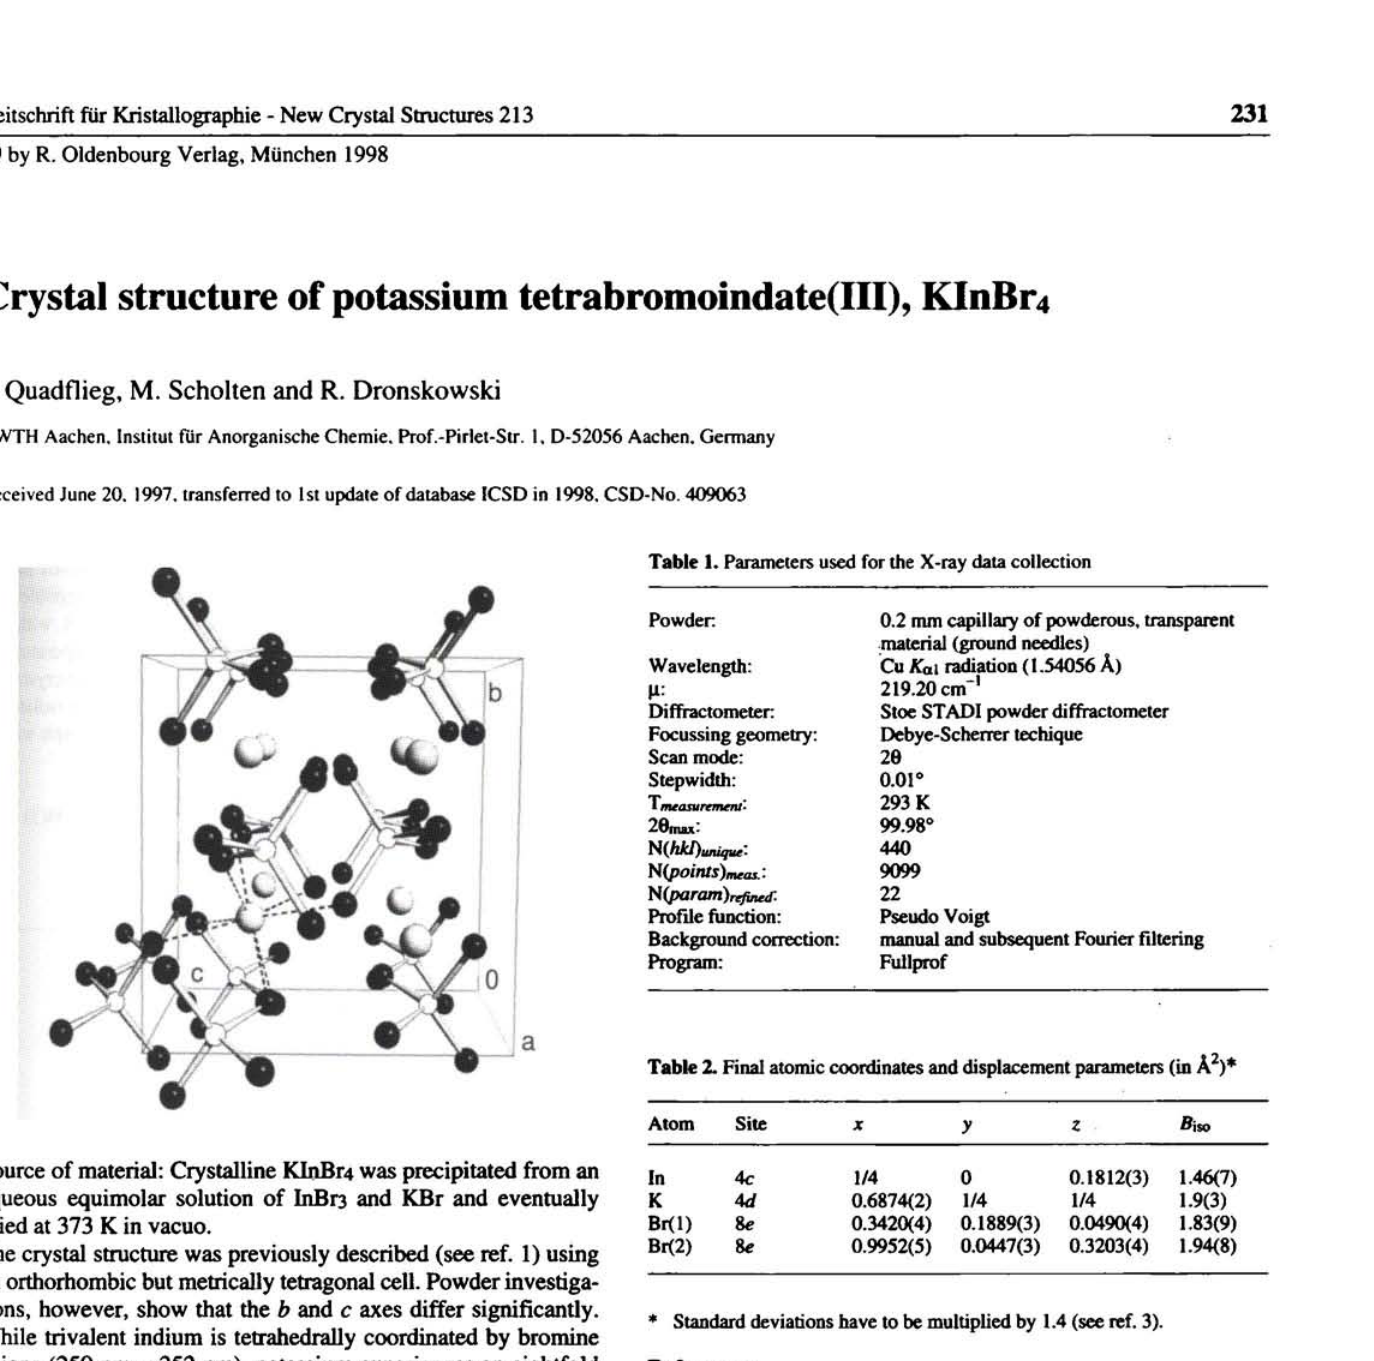
Table 1. Parameters used for the X-ray data collection